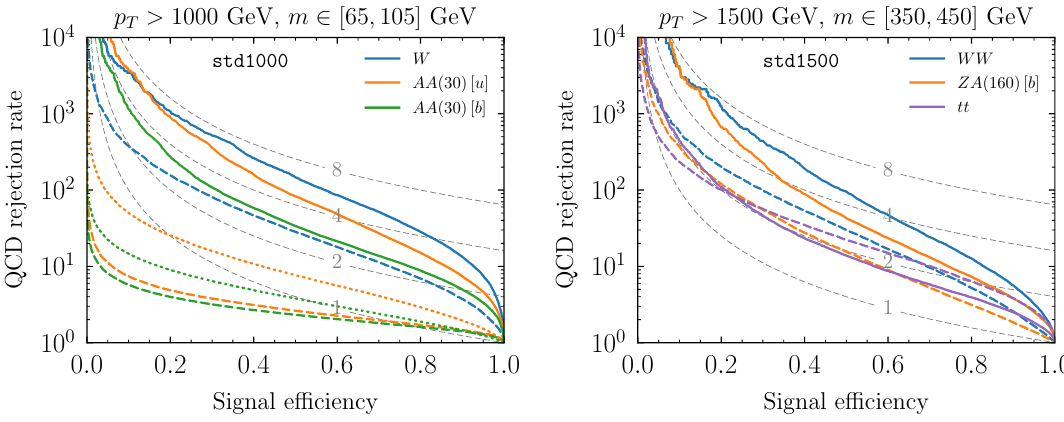
Figure 4 . Comparison of generic taggers (solid) to selected (cid:28) -ratios (dashed, dotted), for several boosted signals. Left: the generic tagger std1000 is compared to (cid:28) (1) (dashed) for W and two 21 stealth boson signatures, and also with (cid:28) (1) (dotted) for the latter. Right: the generic tagger 42 std1500 is compared to (cid:28) (1) for WW and ZA , and (cid:28) (1) for t (cid:22) t 43 63